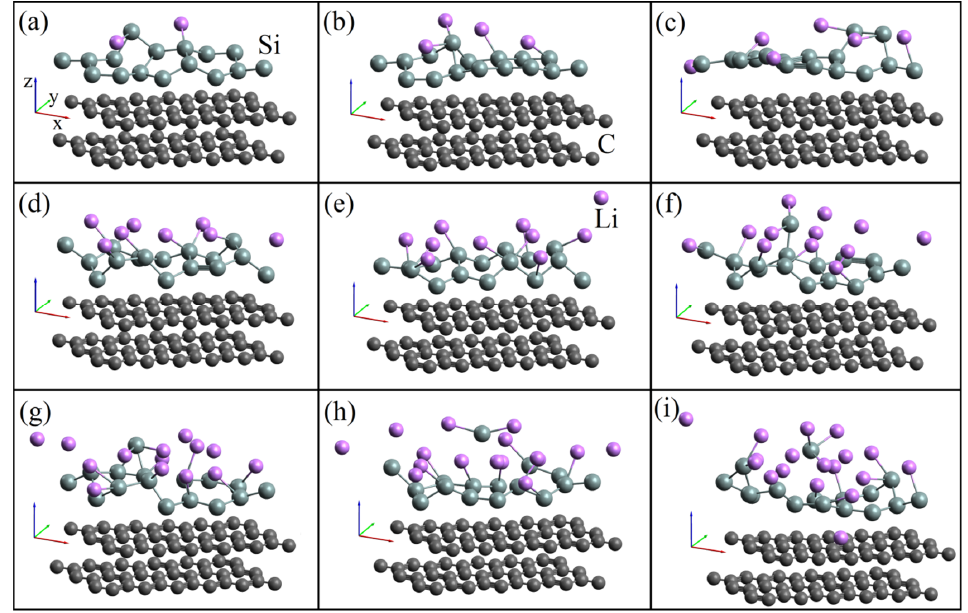
Figure 3. Geometric structures of “silicene-bilayer graphene” systems, which adsorbed lithium in relation to silicon: ( a ) 0.125, ( b ) 0.25, ( c ) 0.375, ( d ) 0.5, ( e ) 0.625, ( f ) 0.75, ( g ) 0.875, ( h ) 1, and ( i ) 1.125.